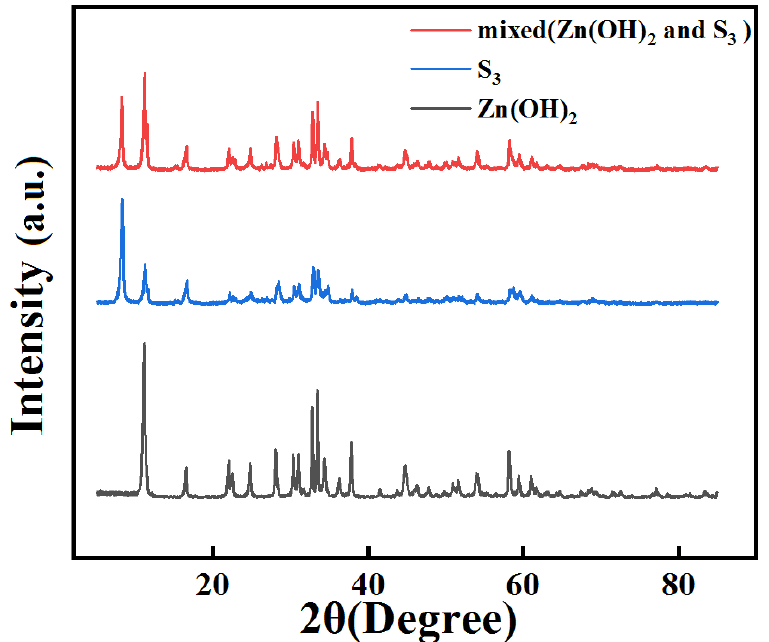
Figure 7. XRD patterns of Zn(OH) 2 , S 3 , and the mixture of Zn(OH) 2 and S 3 .